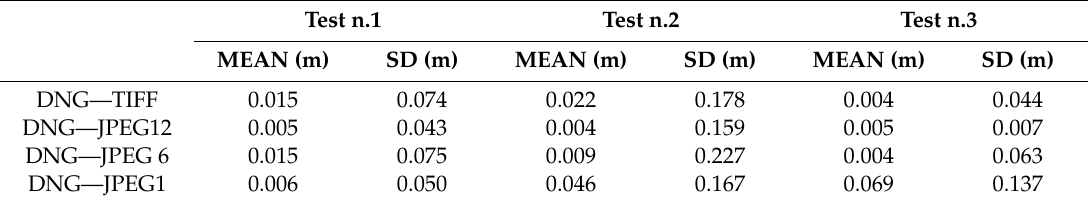
Table 12. Table of mean and standard deviation values of the dense cloud di ff erence than DNG